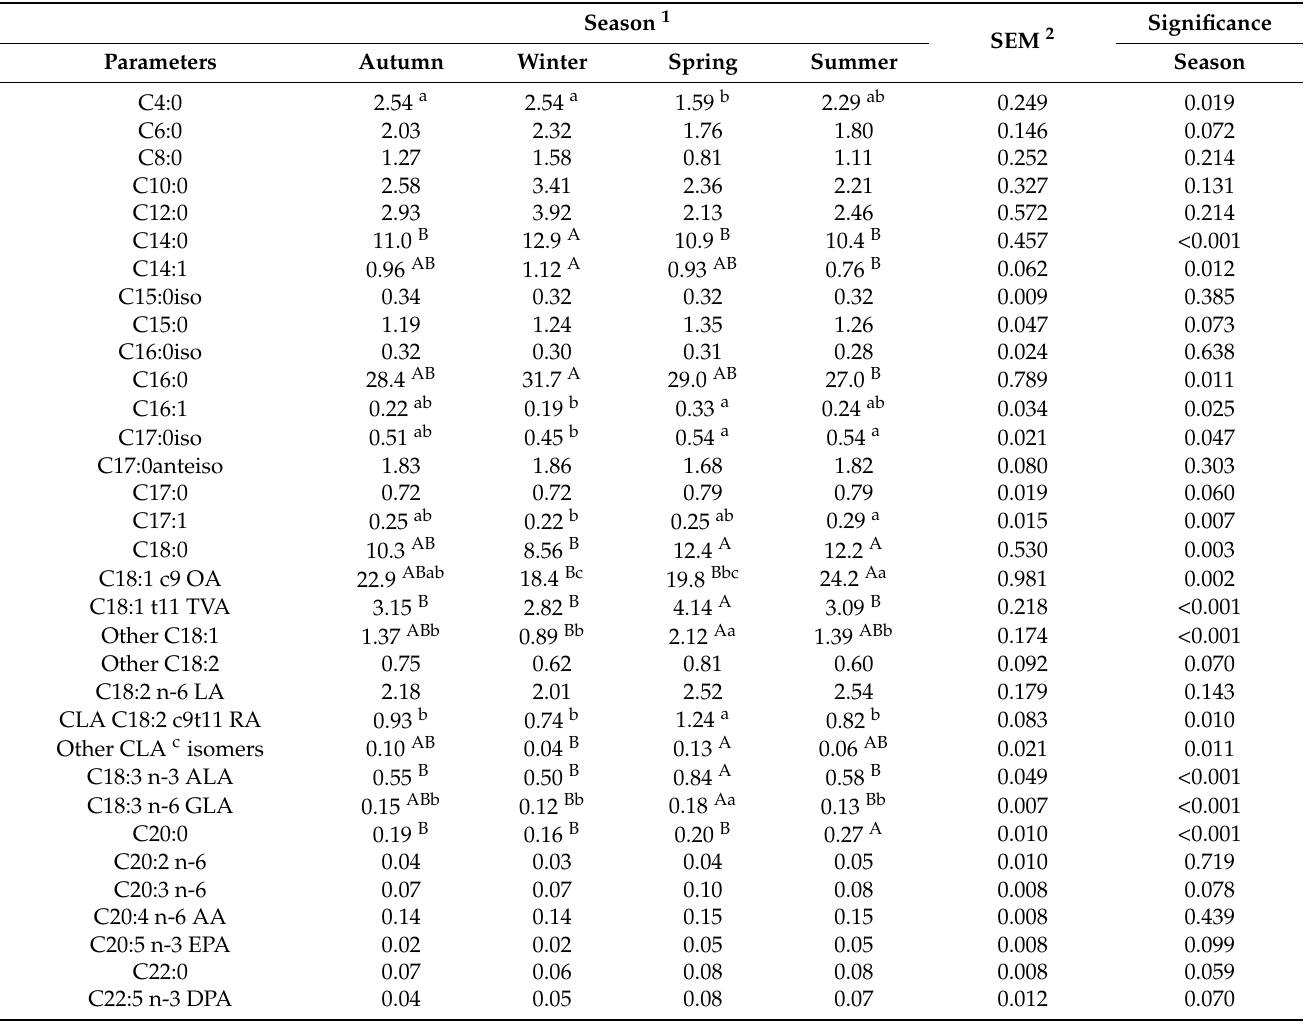
Table 4. Fatty acid profile (g/100 g FA) of Caciocavallo Palermitano cheese in relation to production season. Season 1 SEM 2